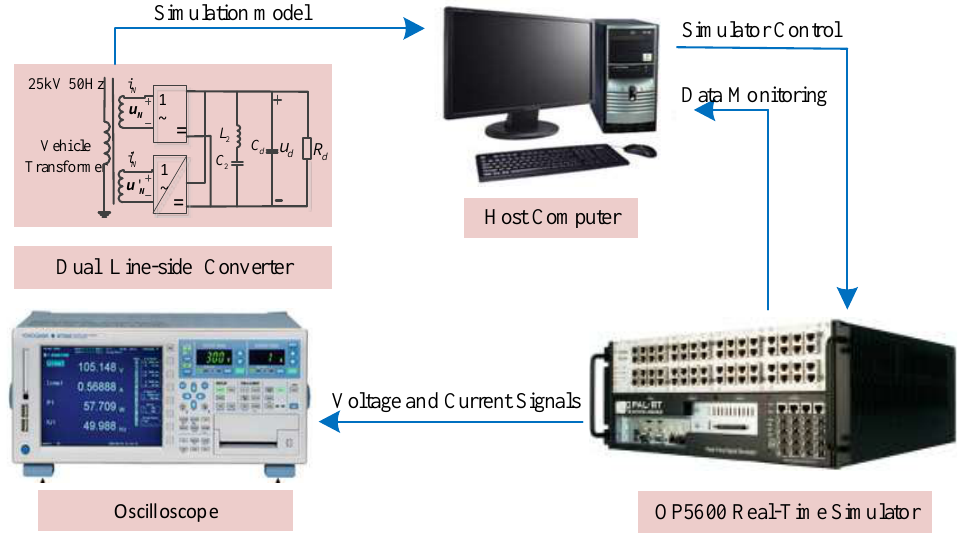
Figure 10. Structure of the real-time online simulation system experimental test platform.